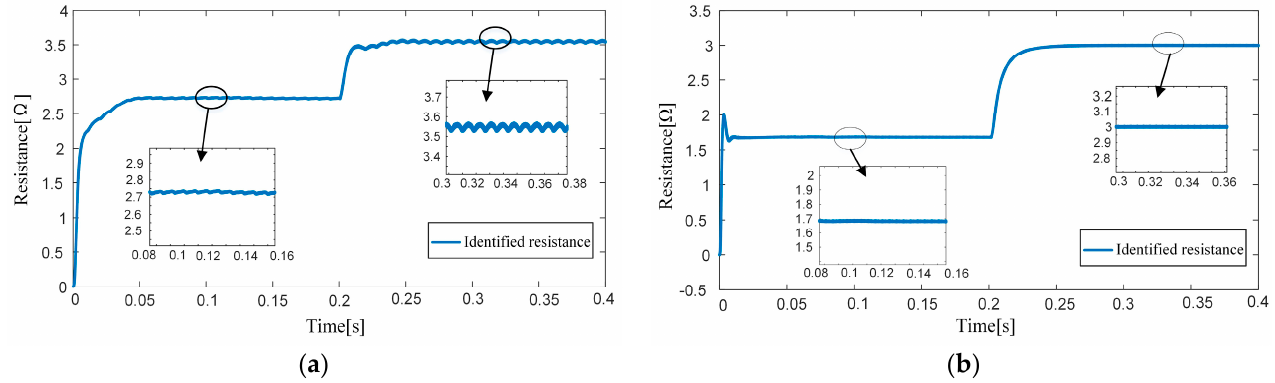
Figure 9. Resistance identification waveform: ( a ) Adaptive sliding mode observer; ( b ) adaptive sliding mode observer + dead zone compensation.